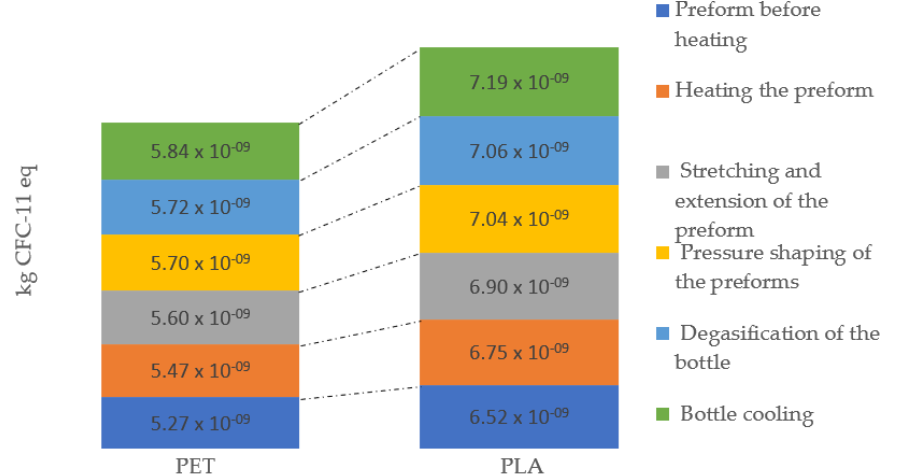
Figure 8. Ozone layer depletion emissions throughout the entire bottle shaping process.